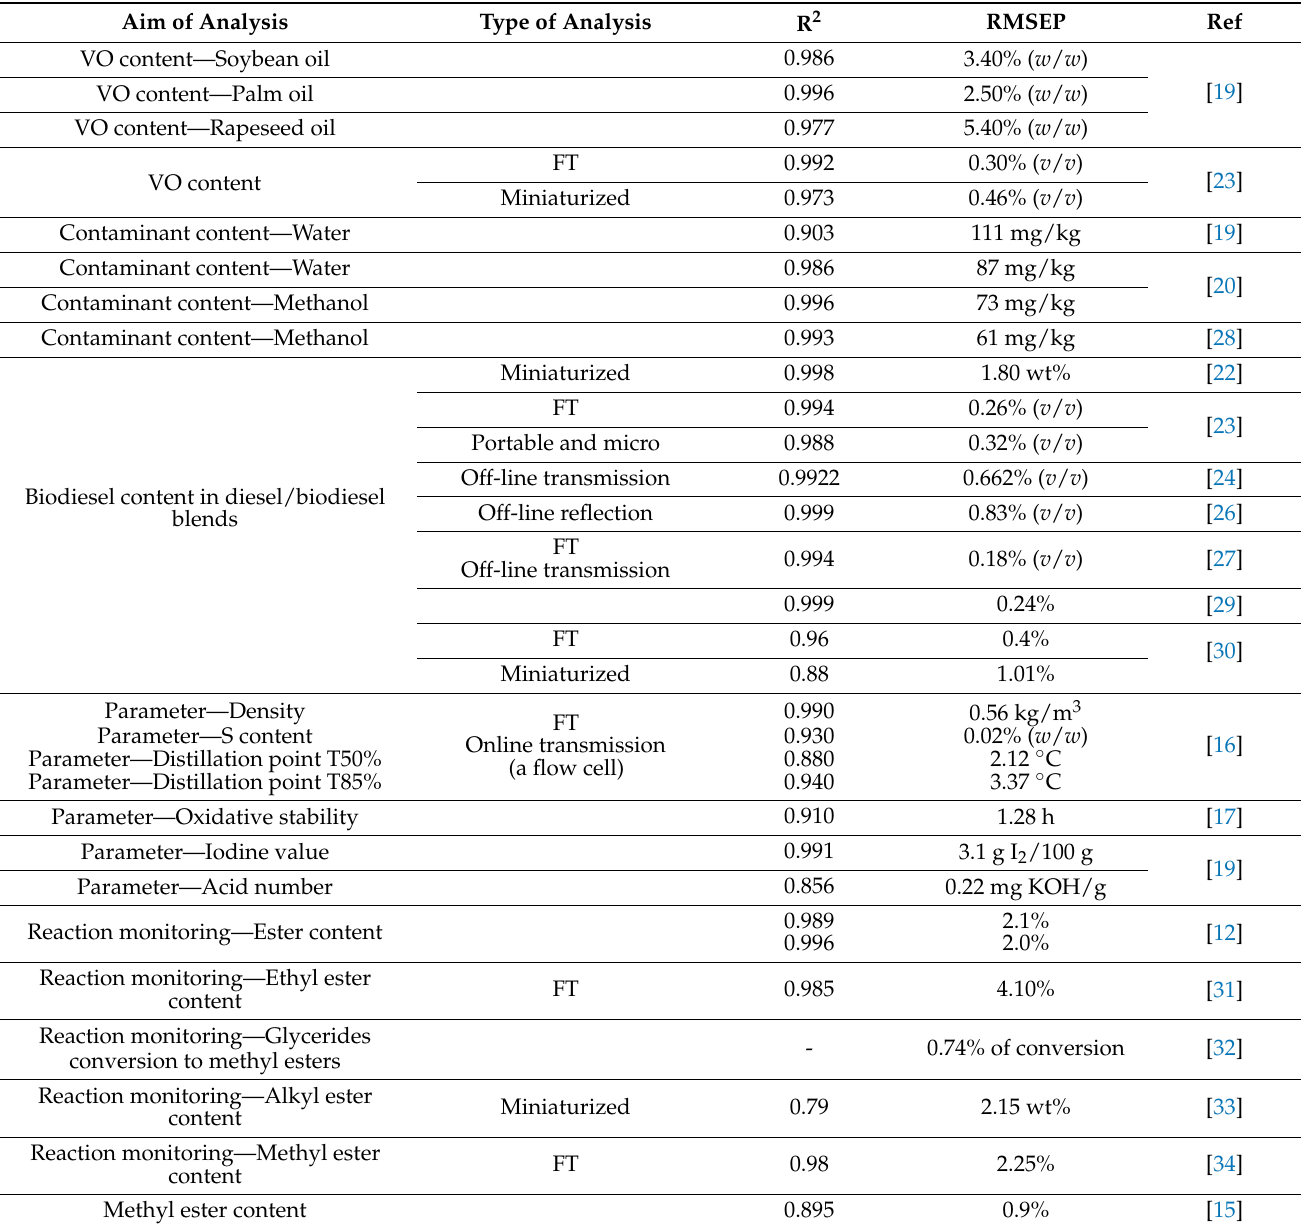
Table 1. Predictability of spectra partial least square (PLS) regression models of biodiesel con- taminants, biodiesel content in diesel blends, biodiesel parameters of the biodiesel synthesis, and ester content. By default, except when stated otherwise, all analyses were made with a dispersive NIR benchtop spectrometer using a transflectance probe coupled to a fiber optic cable enabling in situ